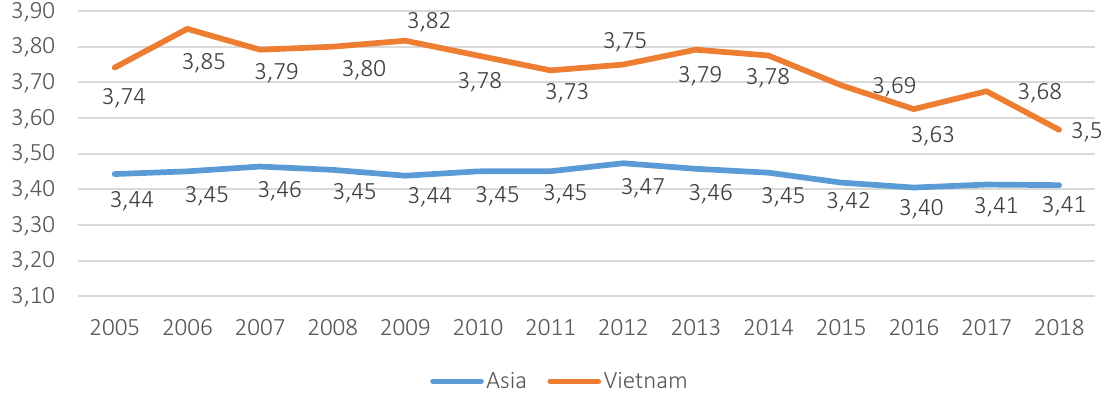
Table 4. Institutional thresholds affecting economic growth in Asia Variables